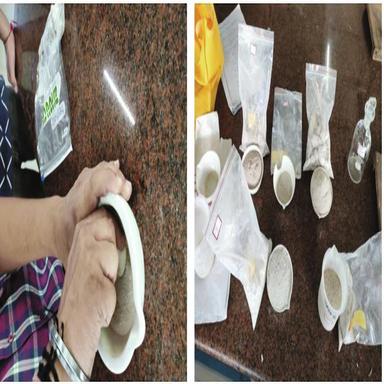
Samples on Lime Mortar.